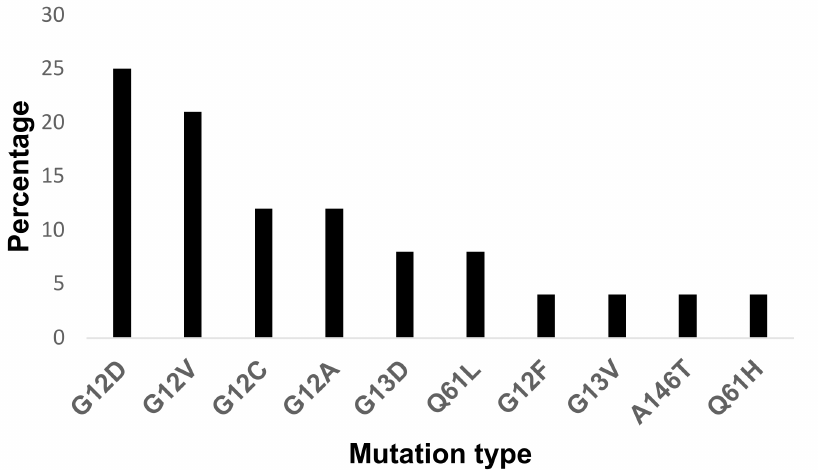
Figure 2. Prevalence of different KRAS mutations in advanced adenocarcinoma